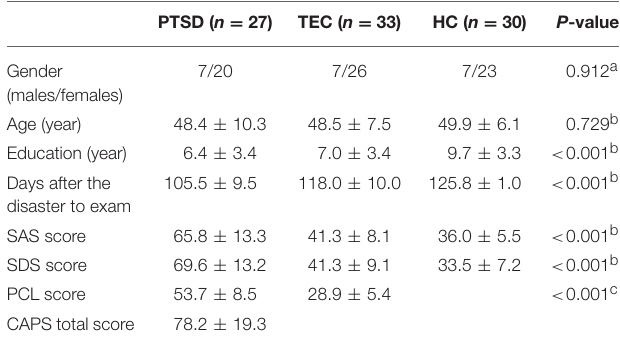
TABLE 1 | Demographic and clinical data of traumatized individuals and healthy controls.